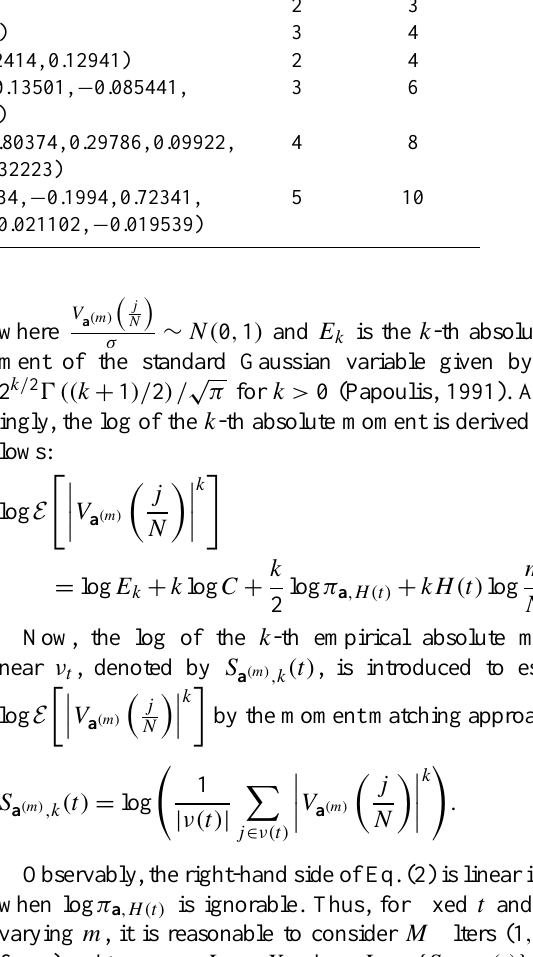
Table 1. Examples for filter a are shown. name filter a order p